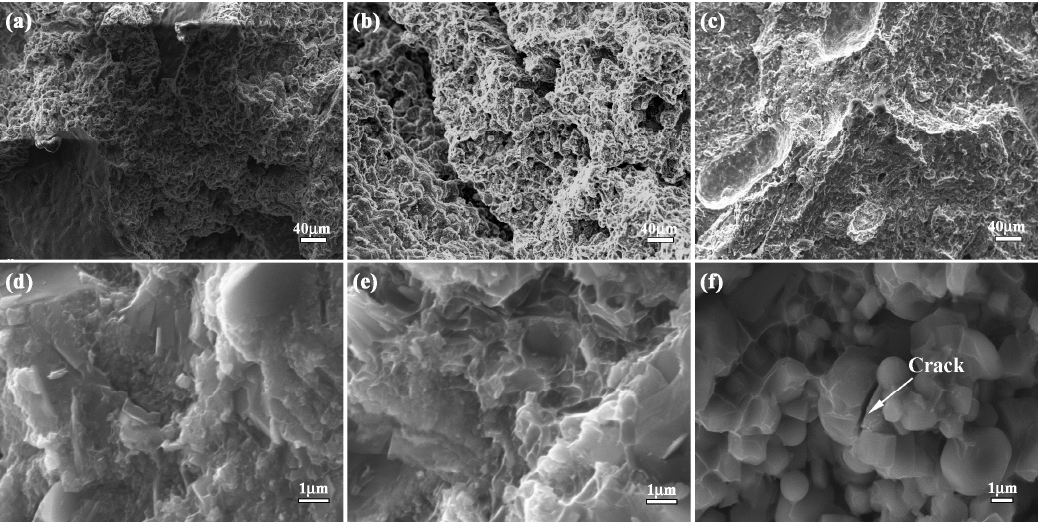
Figure 10. Impact appearance of bionic layered composite ( a ) outer layer ( b ) middle layer ( c ) inner layer ( d ) magnified microstructure of ( a ); ( e ) magnified microstructure of ( b ); and ( f ) magnified microstructure of ( c ).